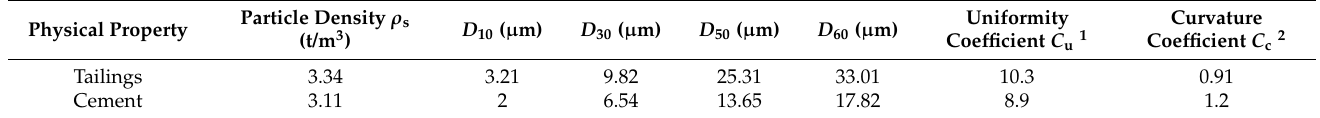
Table 1. Main properties of tailings and cement.